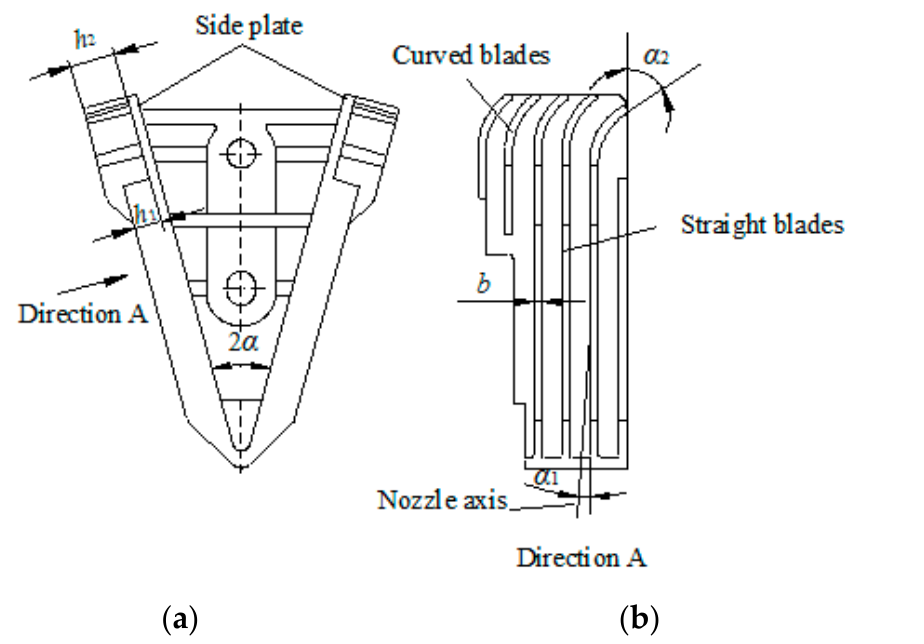
Figure 5. Structural diagram of the drive spoon: ( a ) top view of drive spoon; ( b ) view from direction A. α is the angle between the straight blades and the centreline of water jet ( ◦ ); α 1 is the angle of straight blades into the water jet ( ◦ ); α 2 is the outlet angle of the water jet on the curved blades ( ◦ ); h 1 is the width of the straight blade (mm); h 2 is the width of the curved blade (mm); b is the blade thickness (mm).